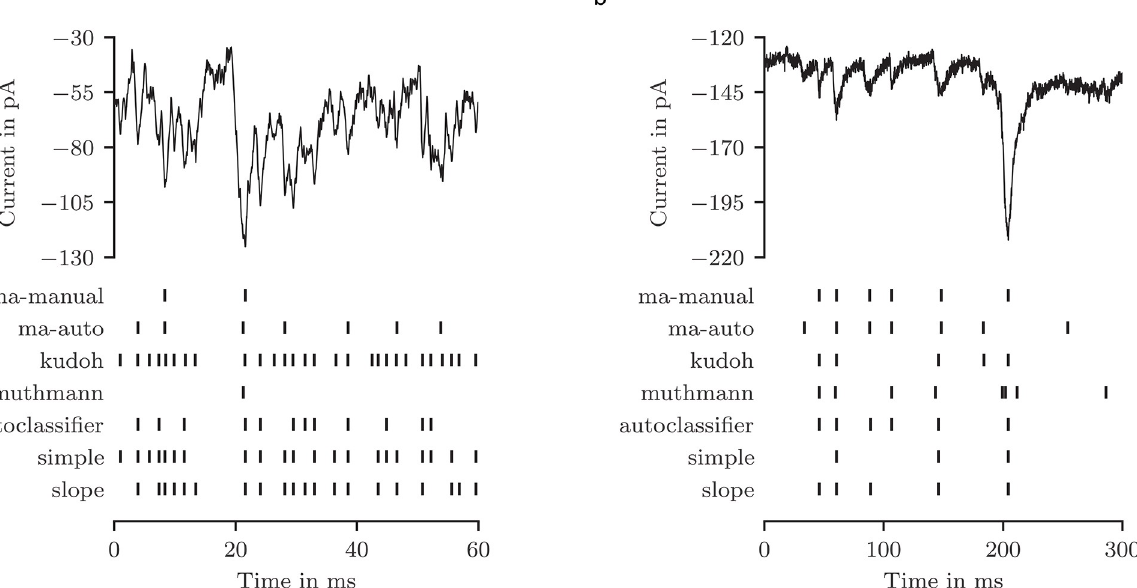
PLOS ONE | https://doi.org/10.1371/journal.pone.0273501 September 19, 2022 4 /